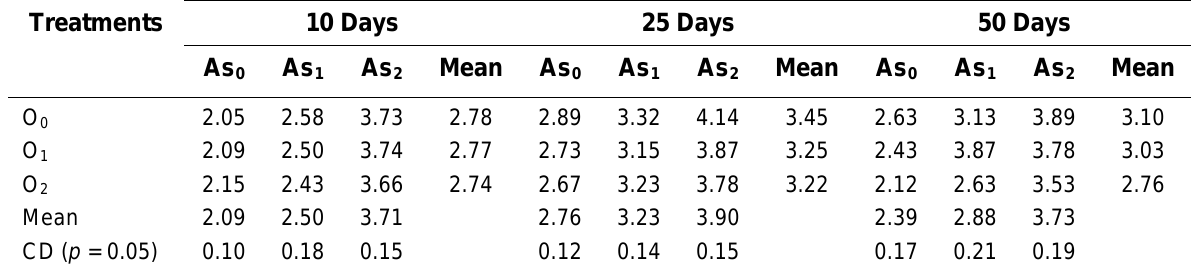
Effect of Well-Decomposed Organic Matter on the Mobilization of Arsenic (mg kg –1 ) in the Soil